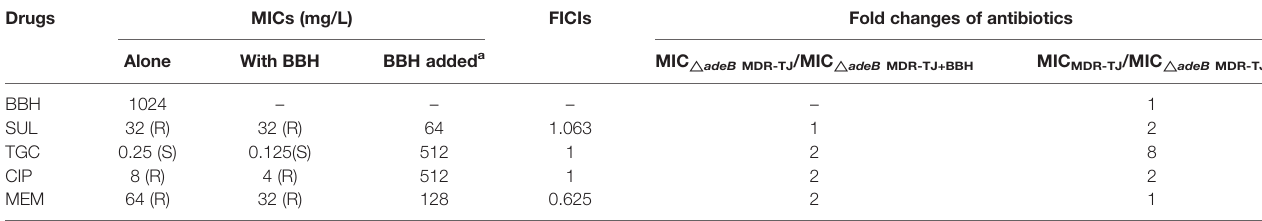
TABLE 3 | MICs in △ adeB